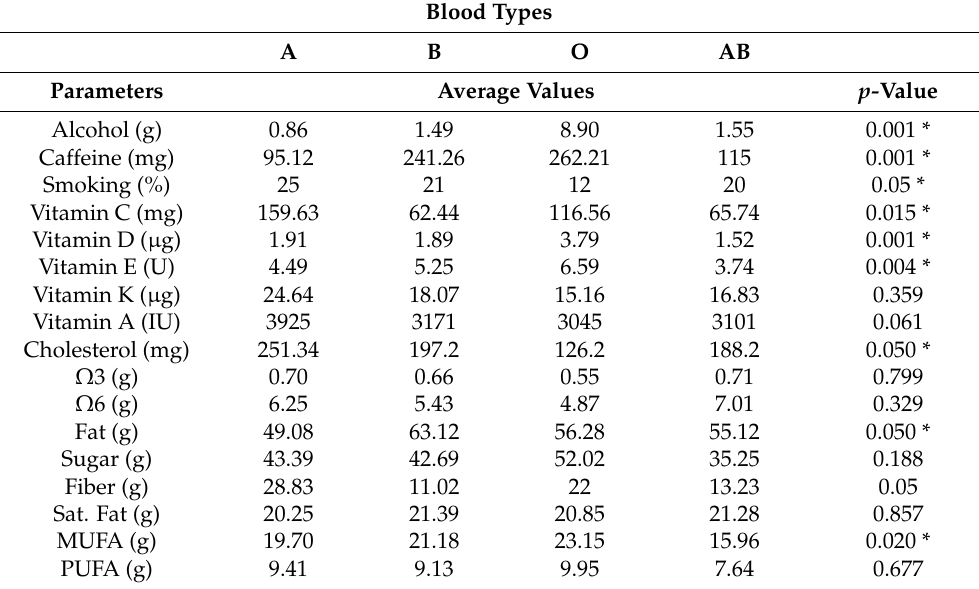
Table 2. Correlation between ABO blood group smoking and dietary intakes in study population. Statistically significant differences are presented with